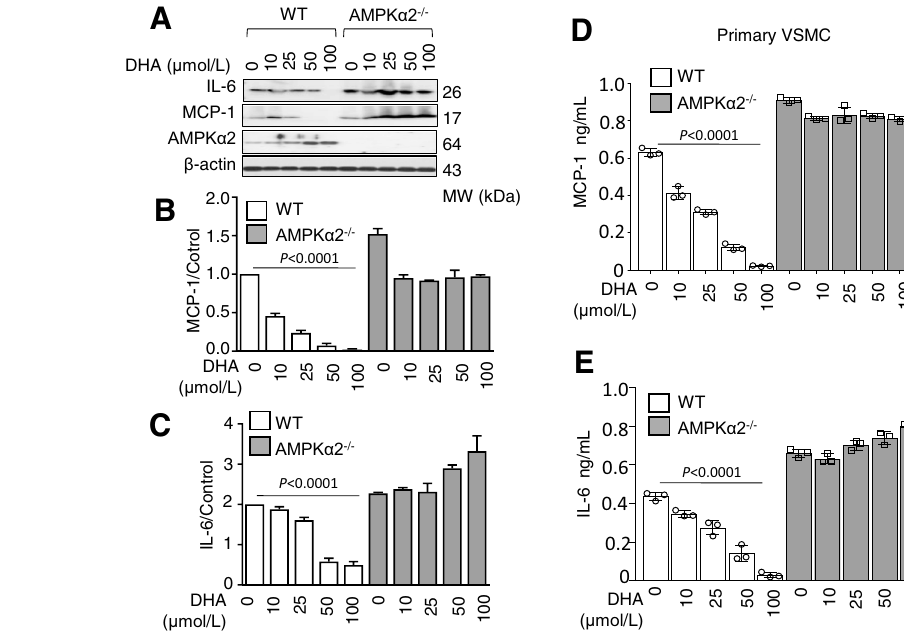
VSMCs with DHA treatment, but no changes were observed in Ffar4 - speci fi c siRNA-transfected AMPK α 2 − / − VSMCs (Fig. 4D – F).